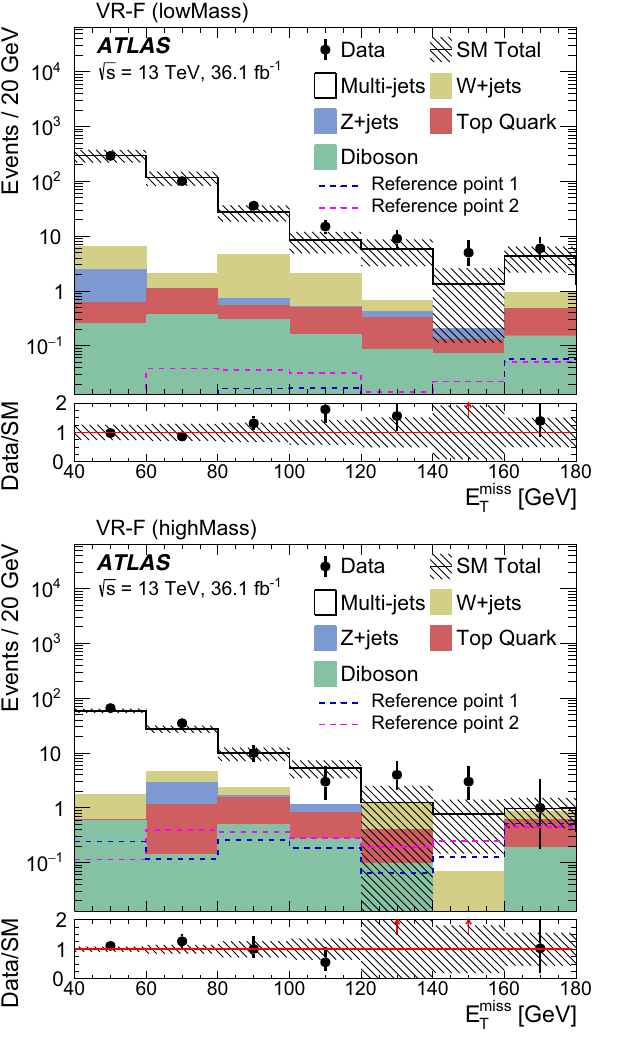
bands represent the combined statistical and systematic uncertainties in the sum of the SM backgrounds shown. For illustration, the distribu- tions of the SUSY reference points (defined in Sect. 3) are also shown as dashed lines. The last bin in the left panels includes the overflow events